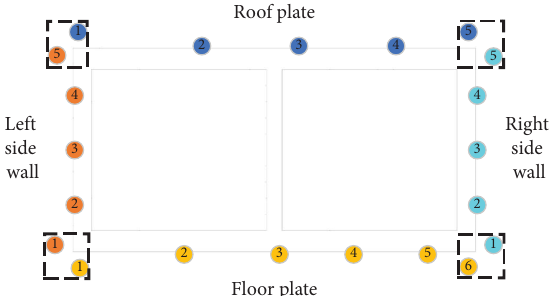
Figure 14: Interested positions in the utility tunnel.